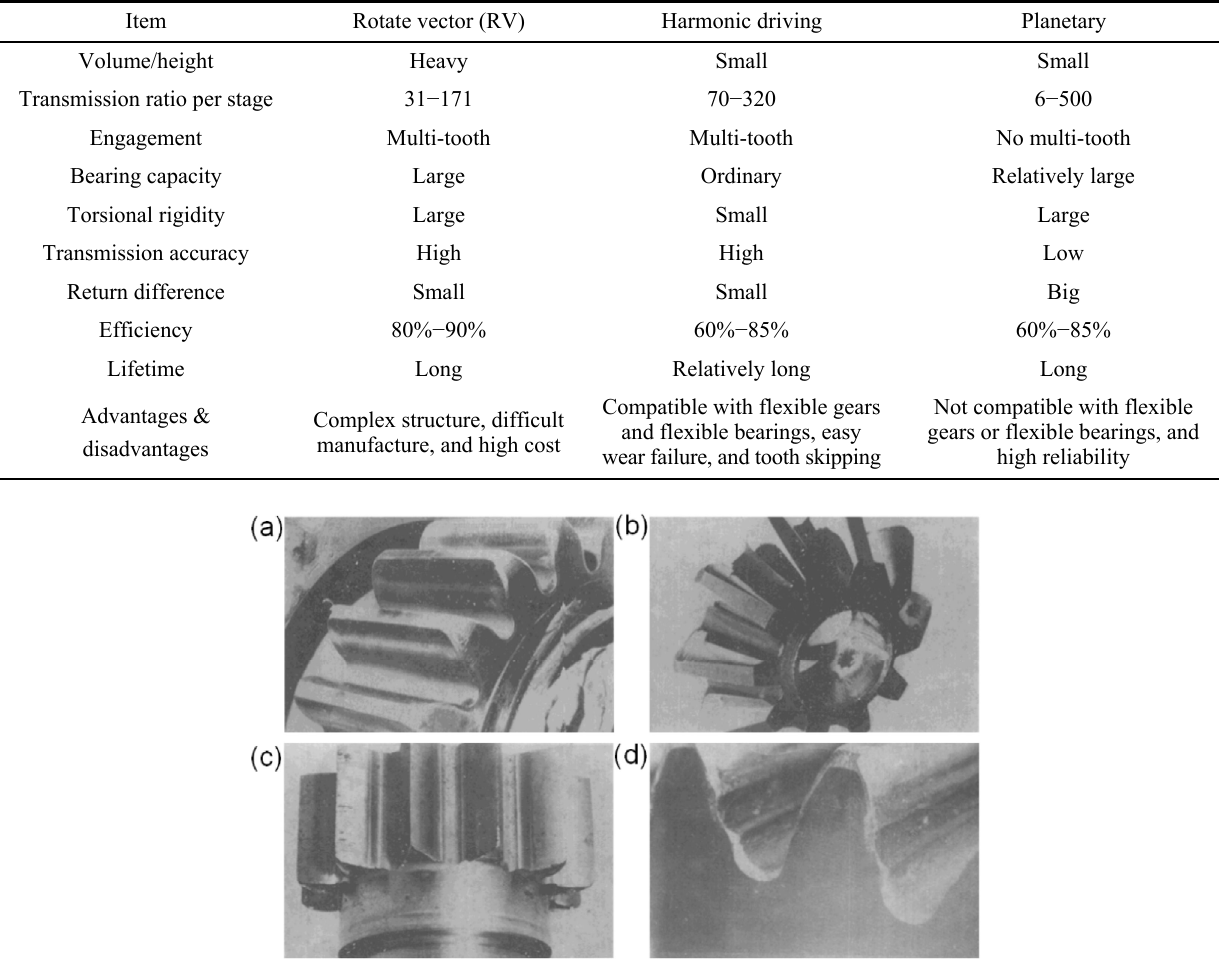
Table 1 Comparison of main technical features of gearboxes.